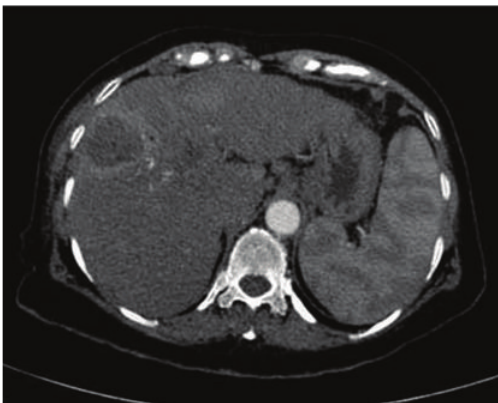
Figure 1: A 70-year-old woman with two lesions of hepatocellular carcinoma. Contrast-enhanced CT scan shows two hepatocellular masses in segment V (treated before with RFA) and II, under the ribs.